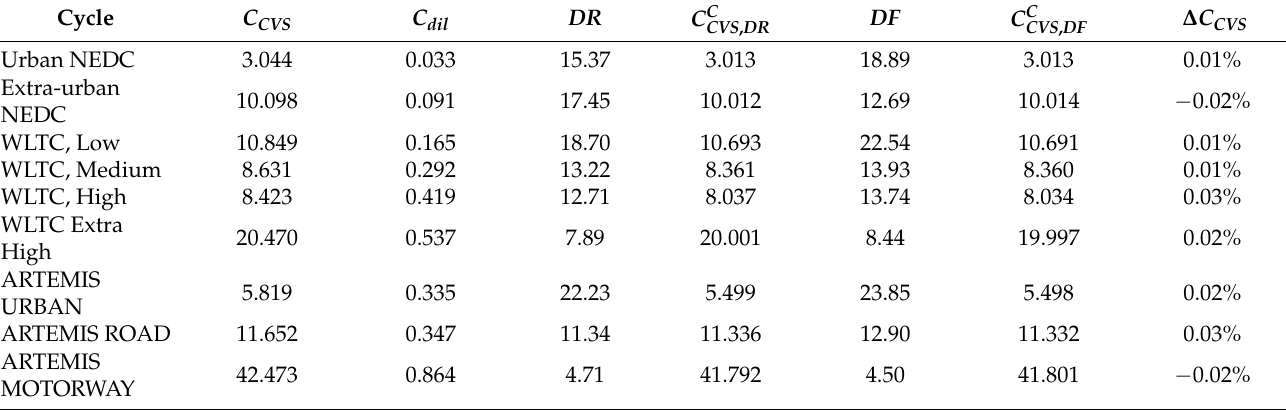
Table A8. The C CVS,corr calculated based on Equations (5) and (21) for Euro 6 NEDC vehicle with SI engine, NO x concentration [ppm].